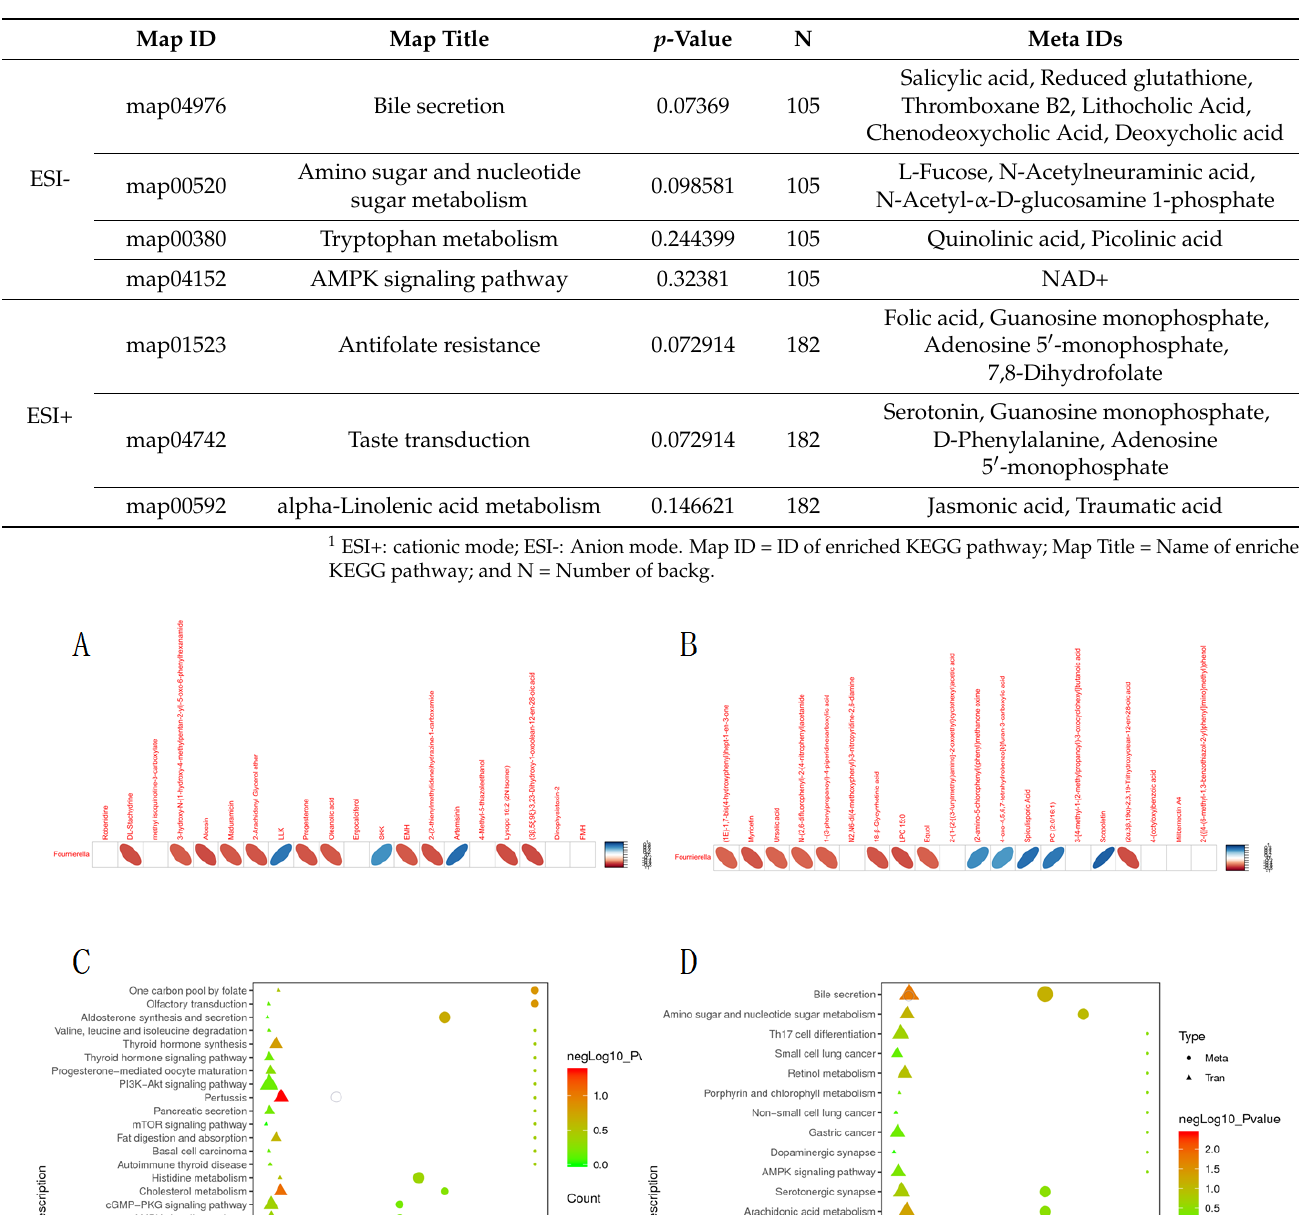
Table 5. KEGG enrichment analysis of differential metabolites in Hyplus rabbit cecum feces samples from diarrheal rabbits (Dia_Ce) and healthy rabbits (Con_Ce) 1 .